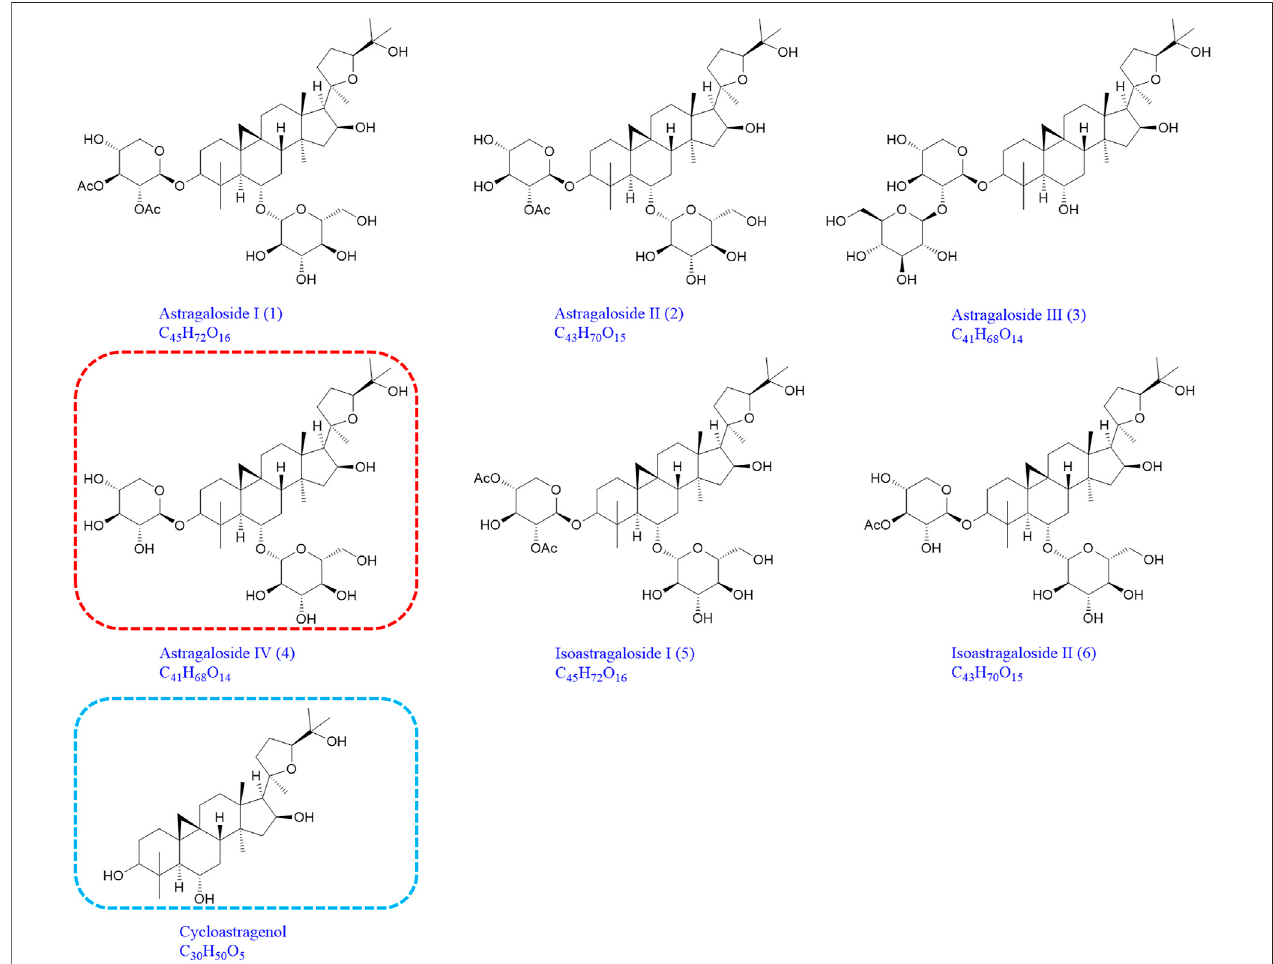
FIGURE 1 | Chemical structures of astragaloside I (1), astragaloside II (2), astragaloside III (3), astragaloside IV (4), isoastragaloside I (5), isoastragaloside II (6), and cycloastragenol (the same as 1-M12, 2-M14, 3-M9, 4-M11, 5-M17, and 6-M12).